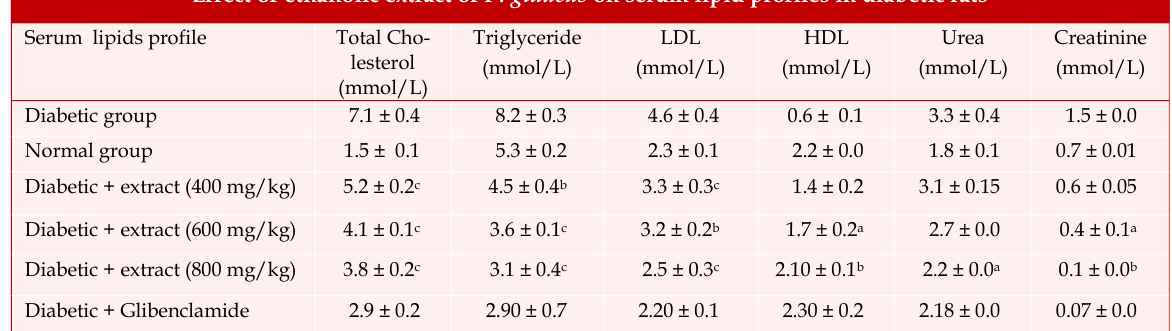
Effect of ethanolic extract of P. glaucus on serum lipid profiles in diabetic rats Serum lipids profile